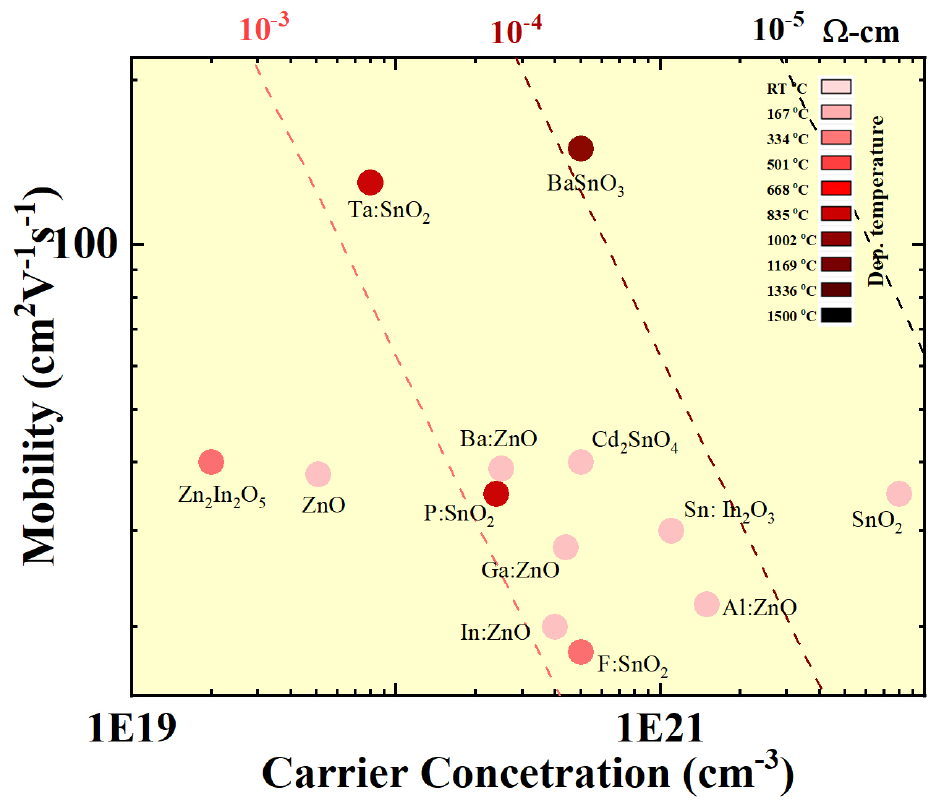
Figure 4. Mobility is plotted against carrier concentration for the highest performing n -type TCMs. Datapoints present the obtained mobility for the corresponding carrier concentration. The colour of the circles signifies the deposition temperature of the film. Dotted lines represent the line of equal resistivity. Table 1. List of some n -type TCMs with deposition methods and optoelectronic